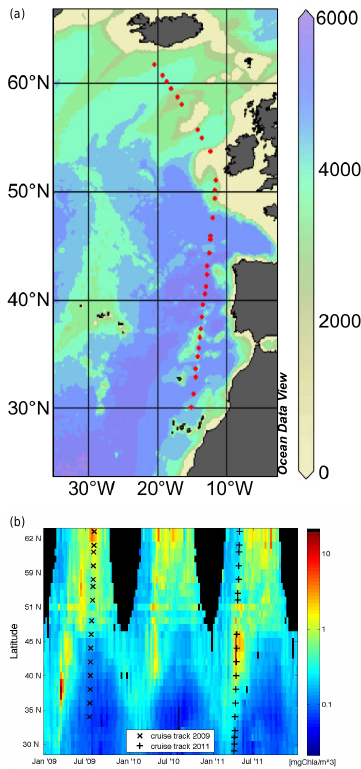
Figure 1. (a) Bathymetry of the North Atlantic with the track of the STRATIPHYT cruises. The colours show the water depth in me- tres. (b) MODIS Aqua chlorophyll a surface concentration plotted along the track in (a) . The black crosses and pluses indicate mea- surement stations during the STRATIPHYT cruises in summer 2009 and spring 2011,